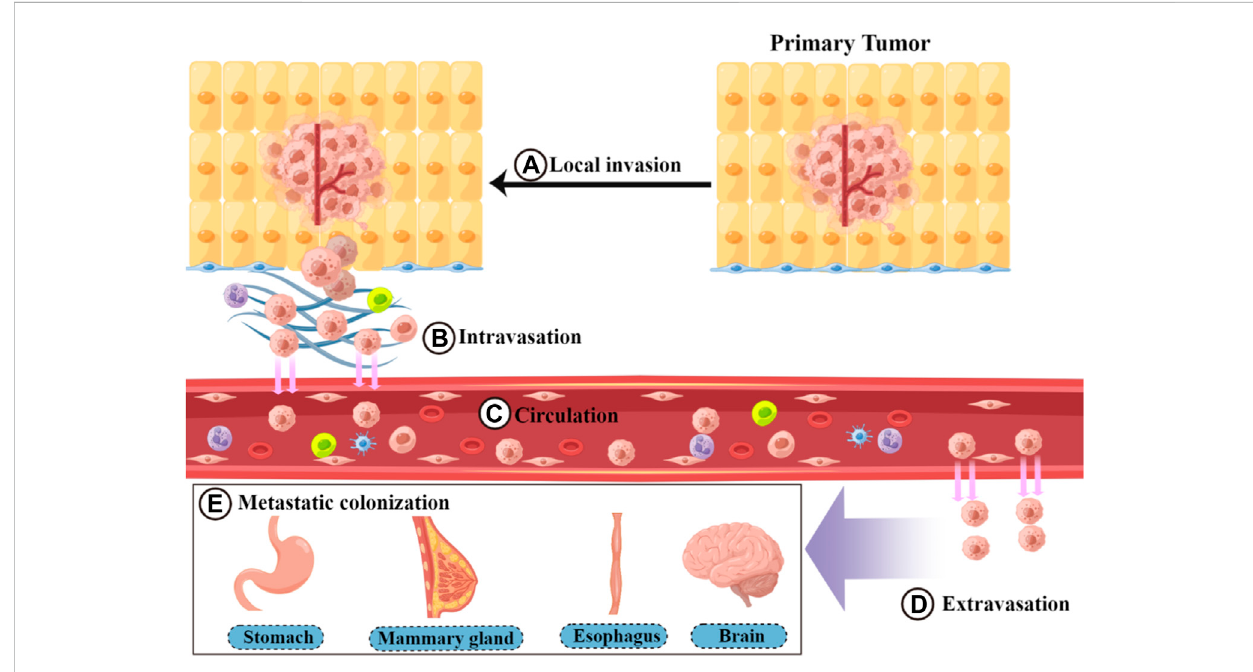
FIGURE 1 Process of the invasion – metastasis cascade. The invasion – metastasis cascade is complex and includes the following steps: (A) local invasion, (B) intravasation, (C) circulation, (D) extravasation, and (E) metastatic colonization.